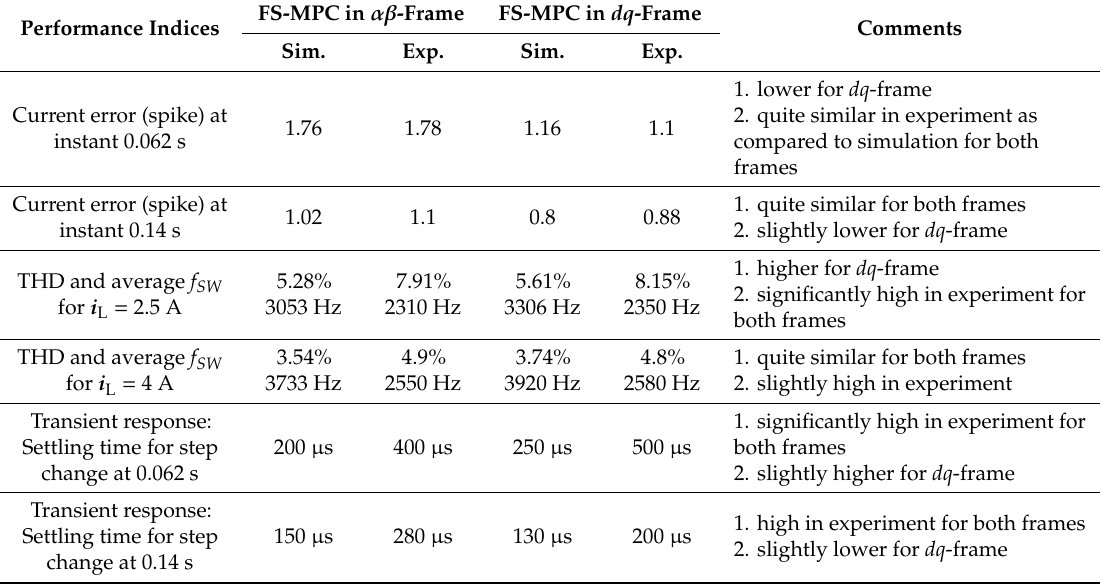
Table 4. Comparative analysis chart for the FS-MPC in two frames.